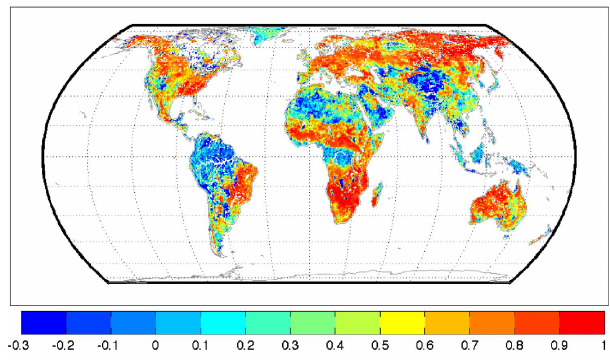
Fig. 6. Map of correlation between monthly variation (time series) of emissivity polarization difference at 10.7GHz (H-V) and NDVI monthly mean variation for time period of January 2003 to Decem- ber 2007.